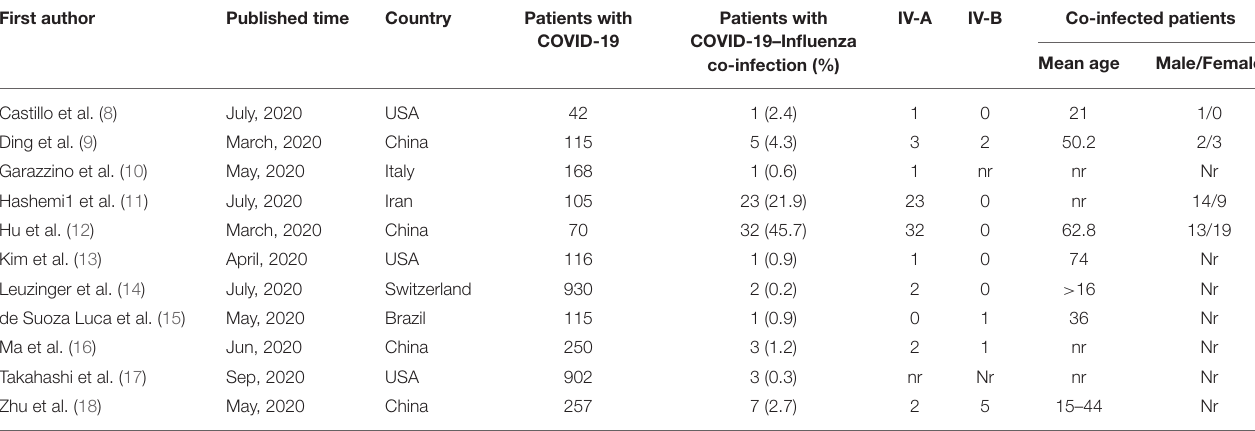
TABLE 1 | Characteristics of included prevalence studies.